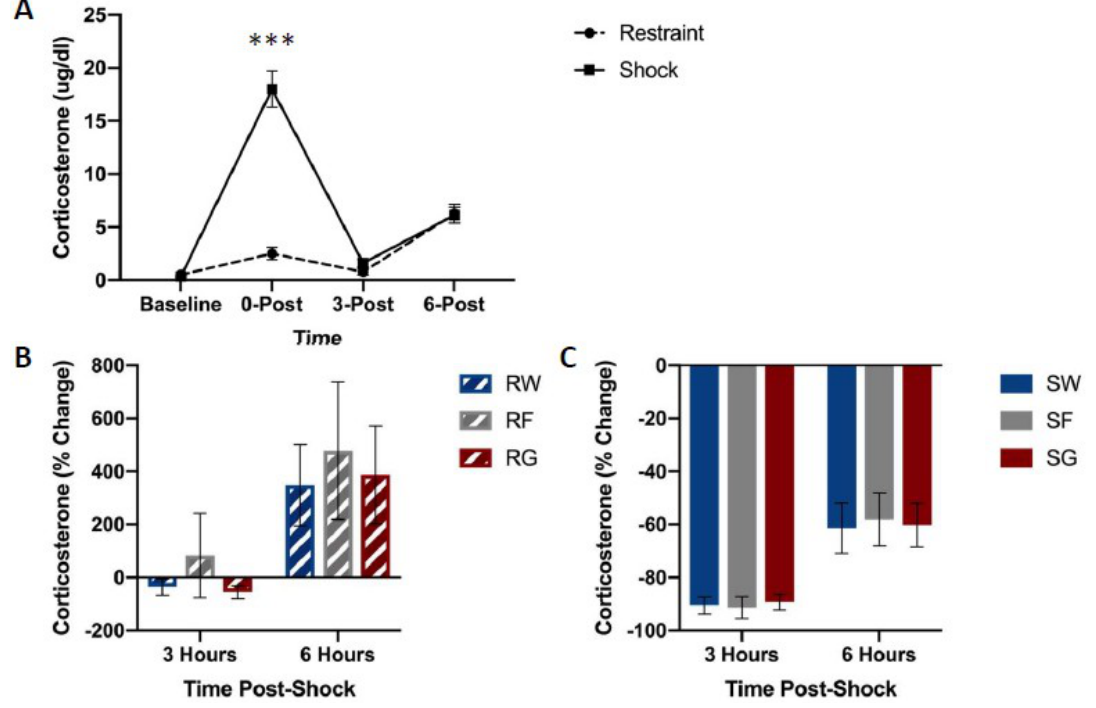
Figure 5. Free corticosterone concentrations between stress treatments (panel A ), and percent change from 0 h post-stress among fluid conditions in restraint (panel B ) or shock (panel C ) stress treatments. Blood was collected for analysis immediately before the acute stress session, and 0, 3, and 6 h following the acute stress session. Animals received either inescapable and unpredictable shock (S) or simple restraint (R). Following the stress session, animals were given 18-h free access to a 40% glucose cocktail (G), 40% fructose cocktail (F), or water (W). Shocked animals exhibited higher concentrations of free corticosterone immediately after the stress session (0-Post). Error bars denote mean ± SEM. *** p < 0.001 (comparison: Restraint, Shock).